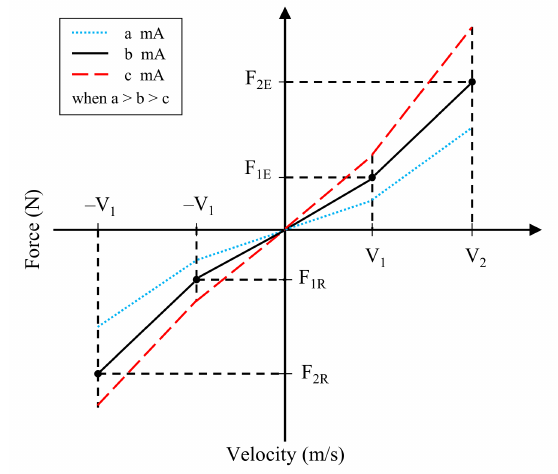
Figure 5. Example of force-velocity characteristic diagram according to test condition.